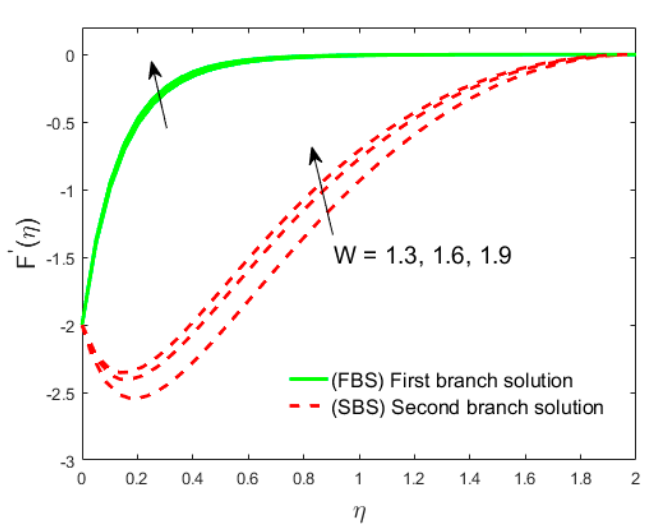
( ) (cid:48) ( η ) . ' F η . Figure 3. The impact of S 1 on F